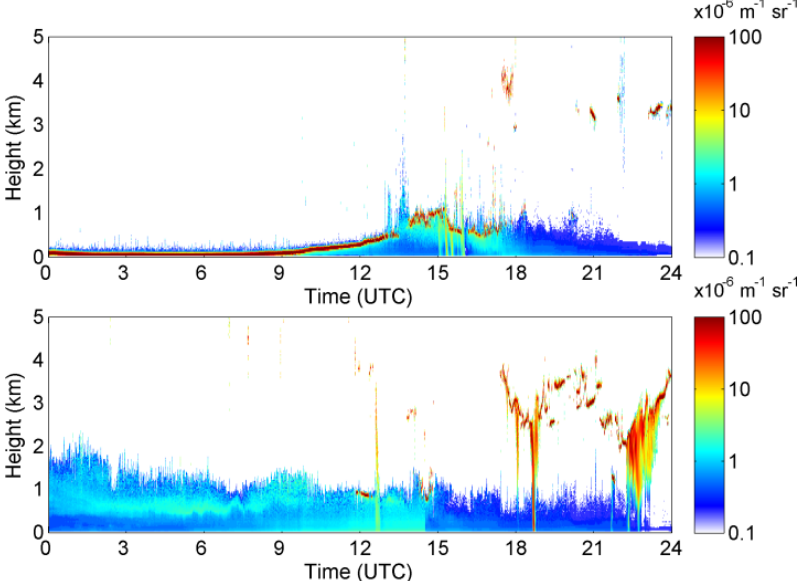
Figure 8. Time series of the attenuated backscatter coefficient measured with ceilometers on 30 July 2010 in Pallas (upper plot) and Sodankylä (lower